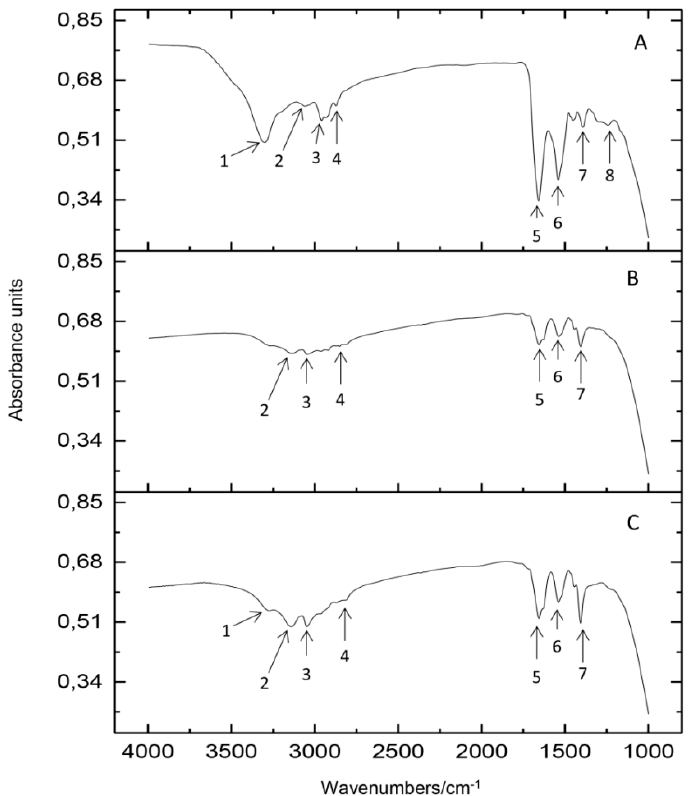
Figure 3. FT-IR spectra of casein before ( A ) and after silver binding reaction depending on the conditions of uptake—under dark ( B ) and light ( C ) conditions; Legend: (1) 3300–3400 cm − 1 , (2) 3150–3250 cm 1 , (3) 3050–3100 cm − 1 , (4) 2700–2800 cm − 1 , (5) 1600–1650 cm − 1 , (6) 1500–1550 cm − 1 , (7) 1400–1450 cm − 1 , (8) 1250 cm − 1 .